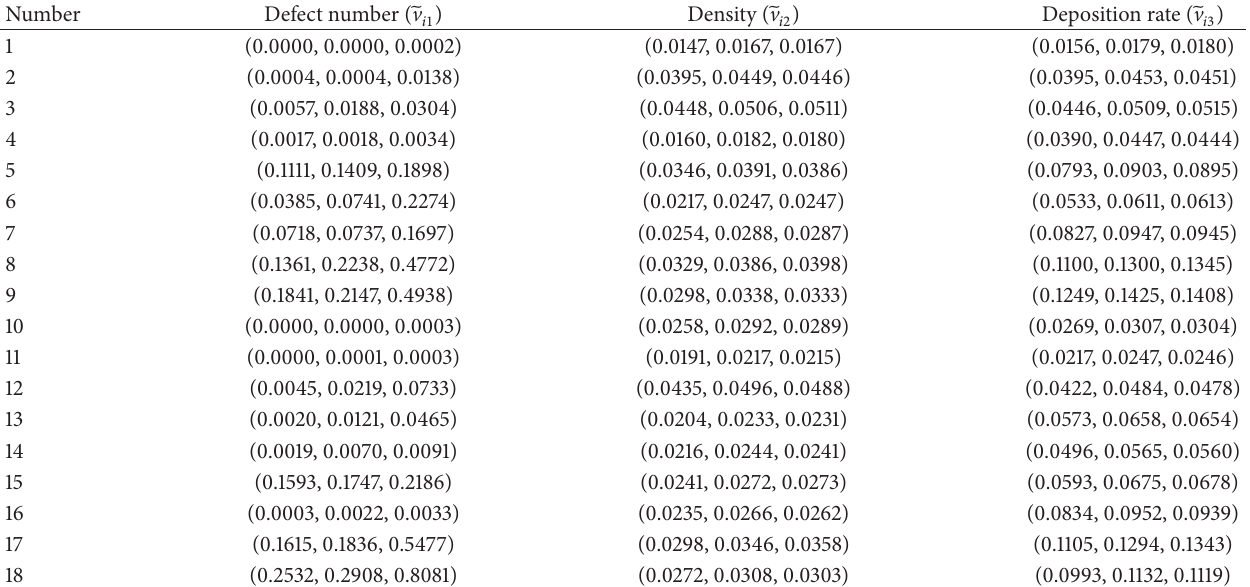
Table 3: Weighted fuzzy decision matrix.